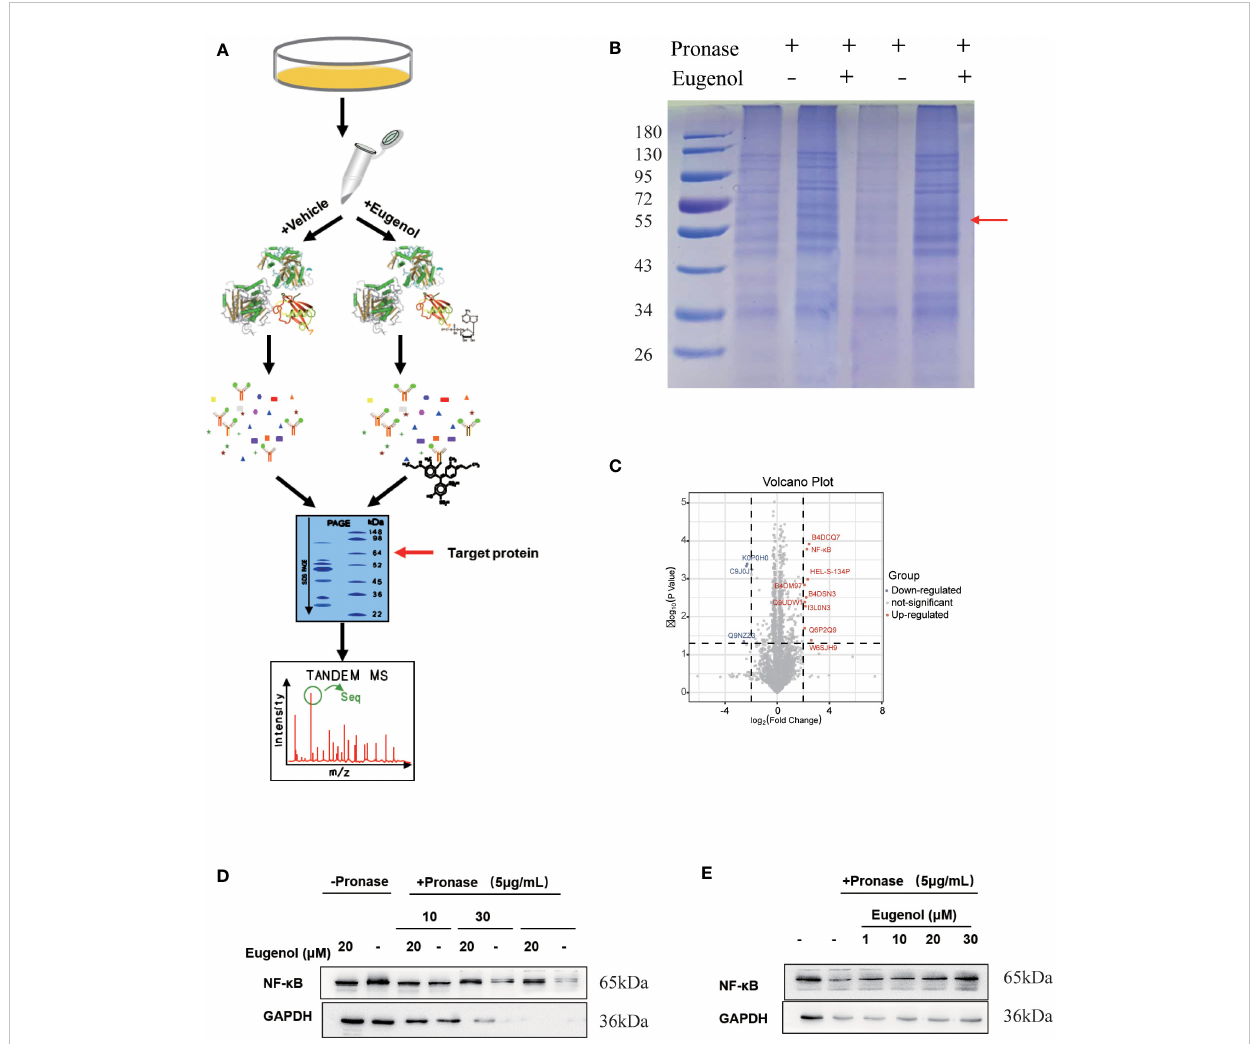
FIGURE 5 The target protein of eugenol in TNBC cells. (A) Work fl ow of drug af fi nity responsive target stability experiment; (B) MDA-MB-231 cells were treated with eugenol (20 m M), and lysates were subject to thermolysin digestion and Coomassie Brilliant Blue staining; (C) Enrichment of proteins in the protected band revealed by mass spectrometry analysis; (D) The DARTS assay for target validation. NF- k B protein stability was increased upon eugenol (20 m M) treatment in MDA-MB-231 lysates. Pronase treatment was conducted for 10, 30, and 60 min; (E) The DARTS assay demonstrated the dose-dependent binding of eugenol to NF- k B. Treatment with pronase (5 m g/mL) performed for 30 min “ - ” represent without the interference of pronase. “ + ” represent the interference of